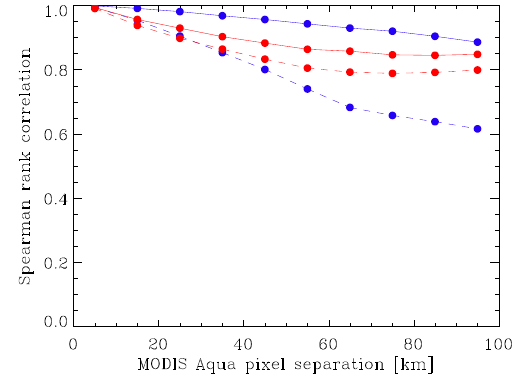
Fig. 1. Spatial correlations among two arbitrary MODIS obser- vations (solid blue: AOT, solid red: AE) or their errors (dashed) as a function of spatial separation. Only MODIS observations co- located with AERONET were